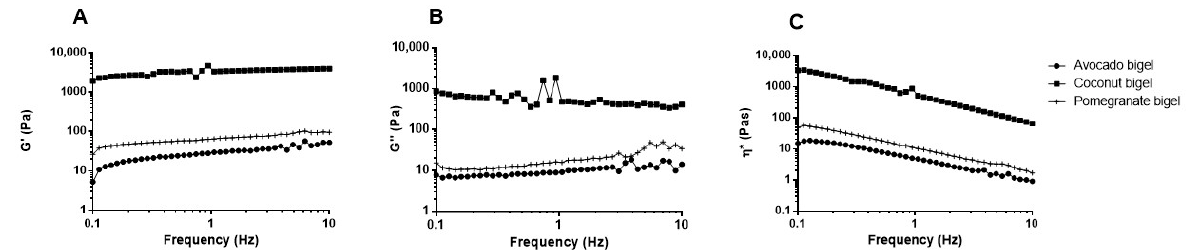
Figure 3. Rheological properties of bigels: ( A ) elastic modulus (G’), ( B ) viscous modulus (G”), ( C ) complex viscosity ( ƞ *), avocado oil ( ● ), coconut oil ( ▪ ), and pomegranate oil ( ⁺ ).